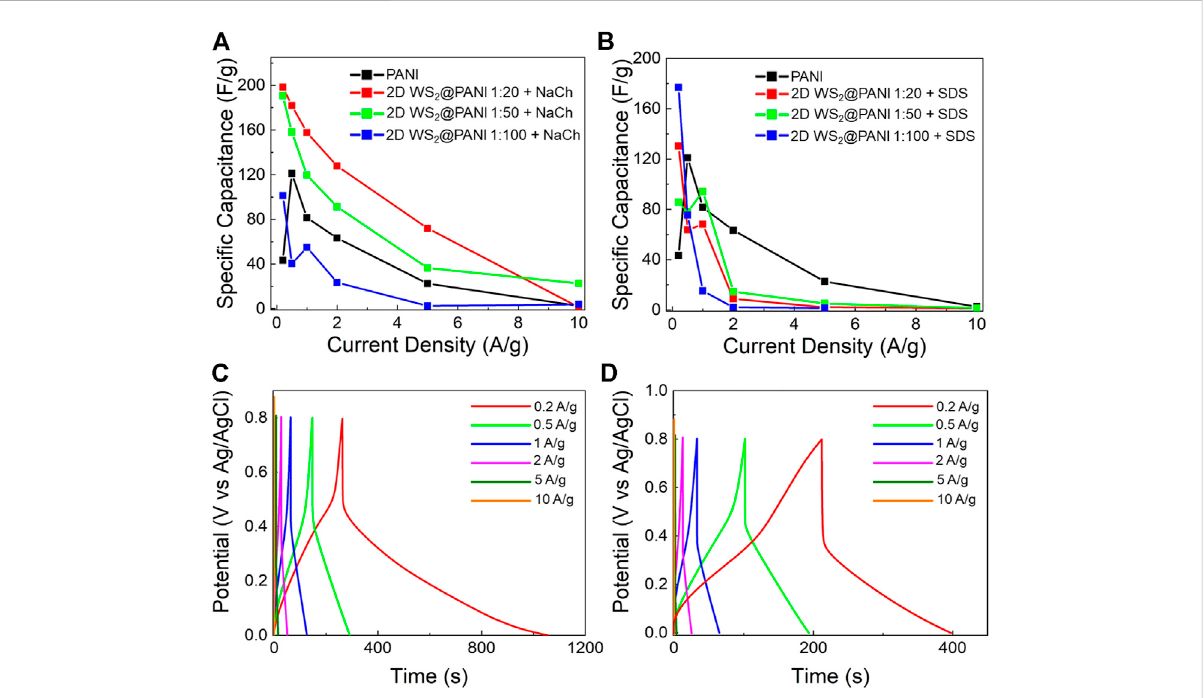
FIGURE 4 Electrochemical performance of 2D WS2@PANI nanohybrids at neutral pH (in 0.5 M Na2SO4 electrolyte). Speci fi c capacitance as a function of current density for 2DWS2@PANInanohybridsatdifferentmolarratios preparedinthepresenceof (A) NaCh and (B) SDS. Thedata for purePANI are also provided for the sake of comparison. GCD curves at increasing current densities for (C) the 1:20 2D WS2@PANI nanohybrid prepared in the presence of NaCh and (D) for pure PANI.